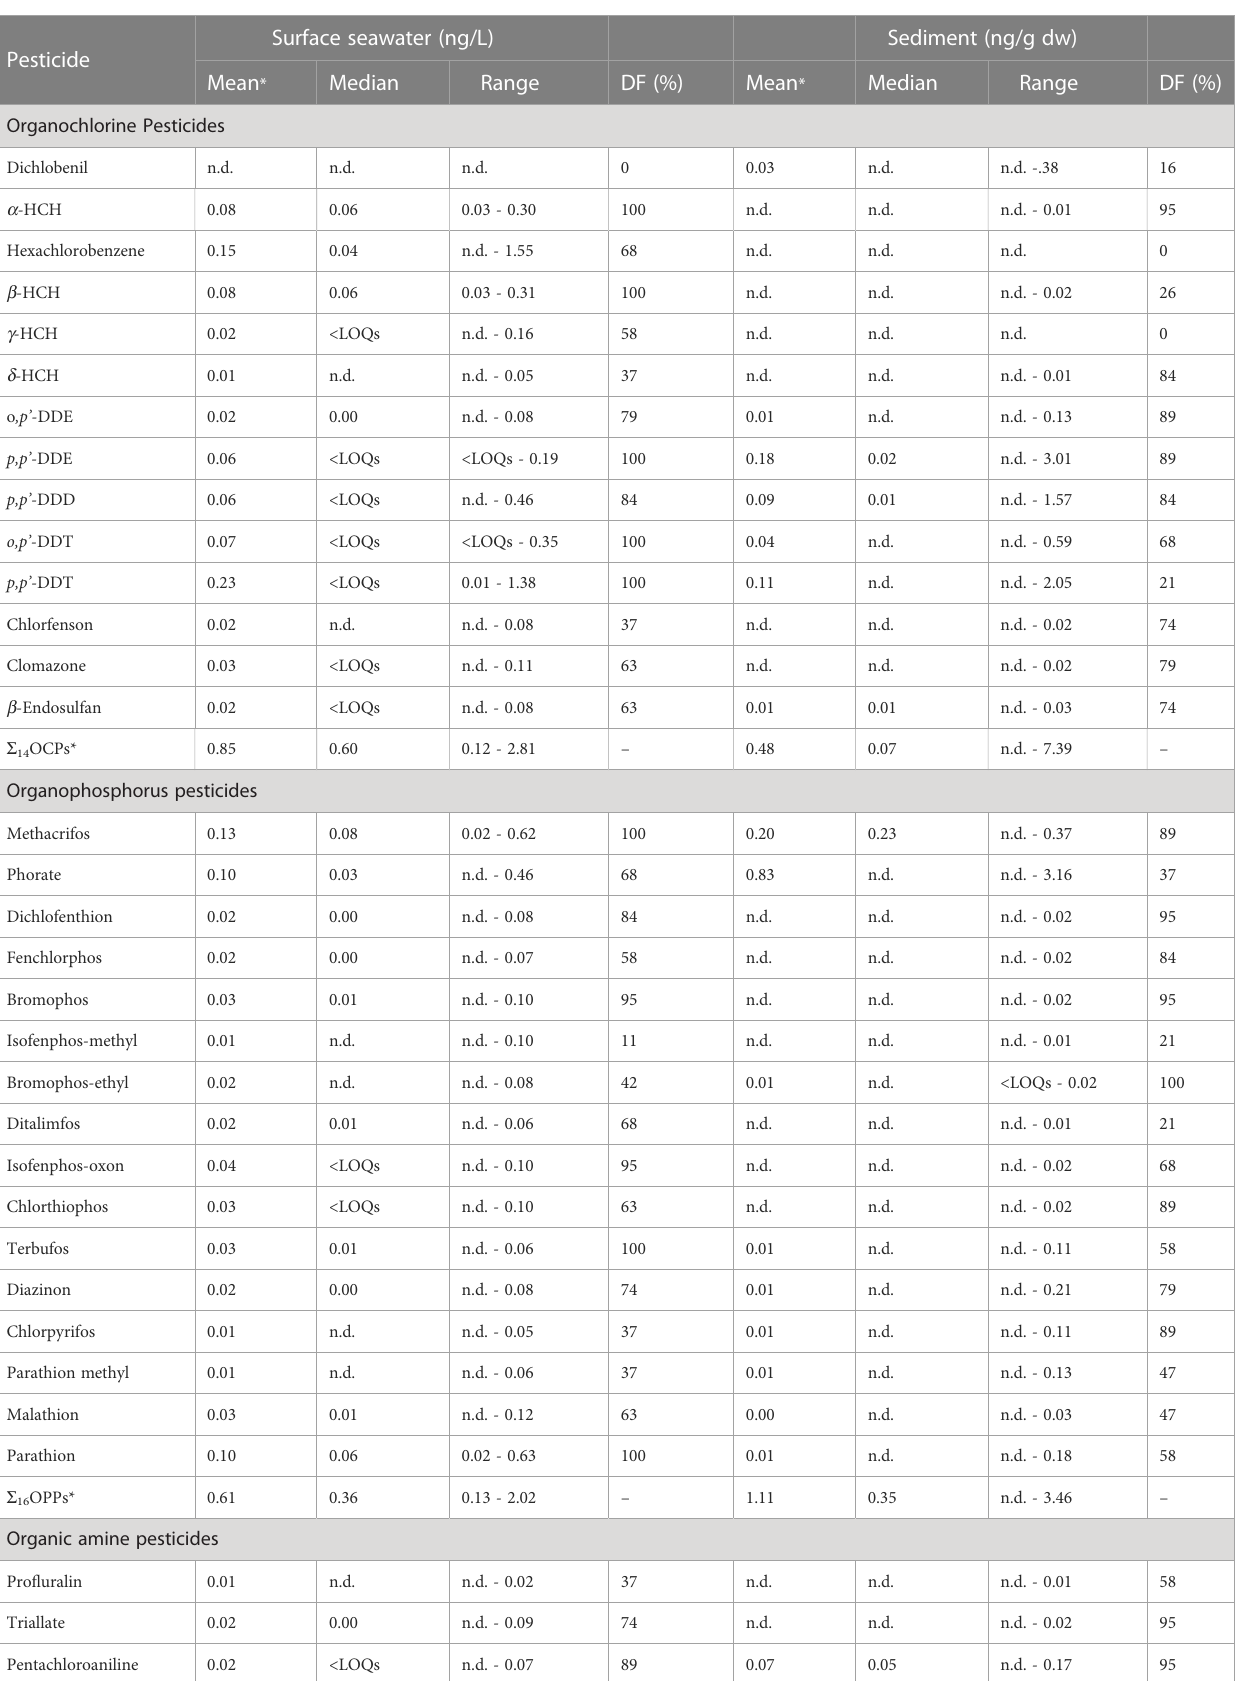
TABLE 1 Concentrations (mean and range) and detection frequency (DF) of pesticides in surface seawater and sediment of the Beibu Gulf.